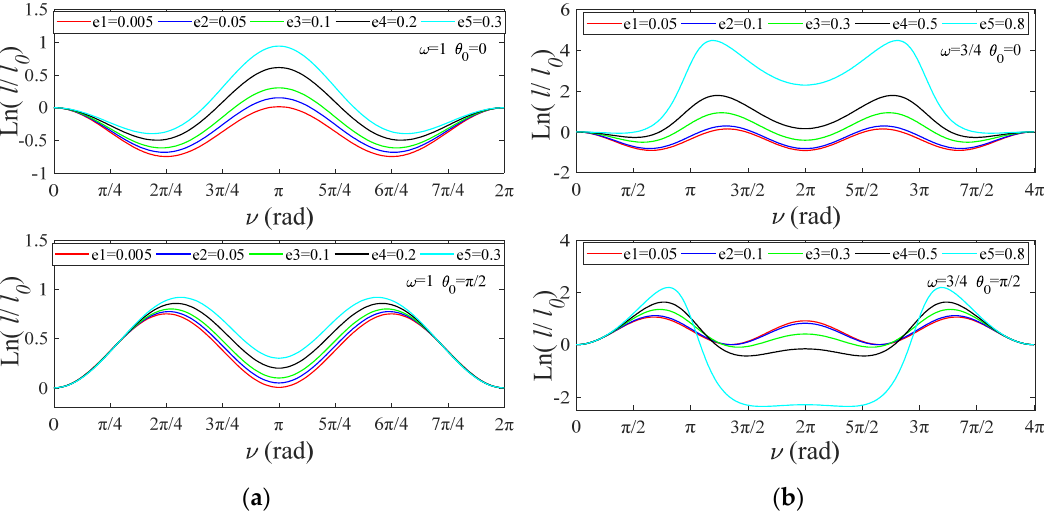
ν , Figure 7. Log ratio of tether length versus ν , θ (cid:48) = const : ( a ) ω = 1, θ 0 = 0 and π /2; ( b ) ω = 3/4,